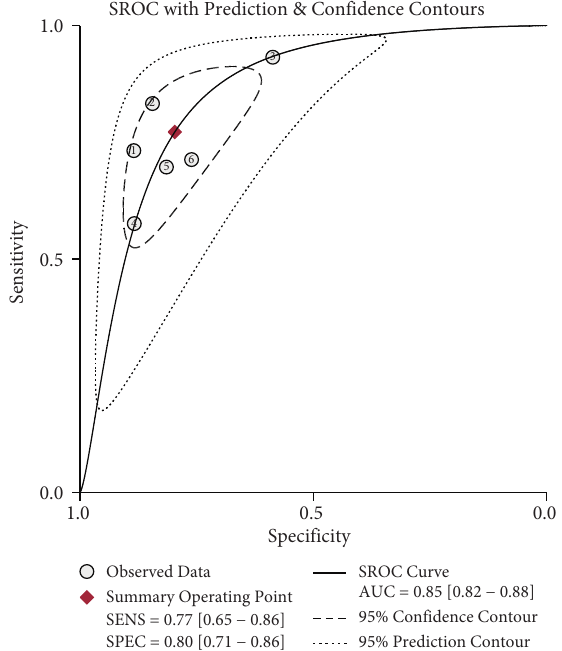
Figure 3: Summary receiver operator curve evaluating digital rectal examination as a diagnostic test for dyssynergic defecation (AUC was 0.85 (95% CI 0.82–0.88)).